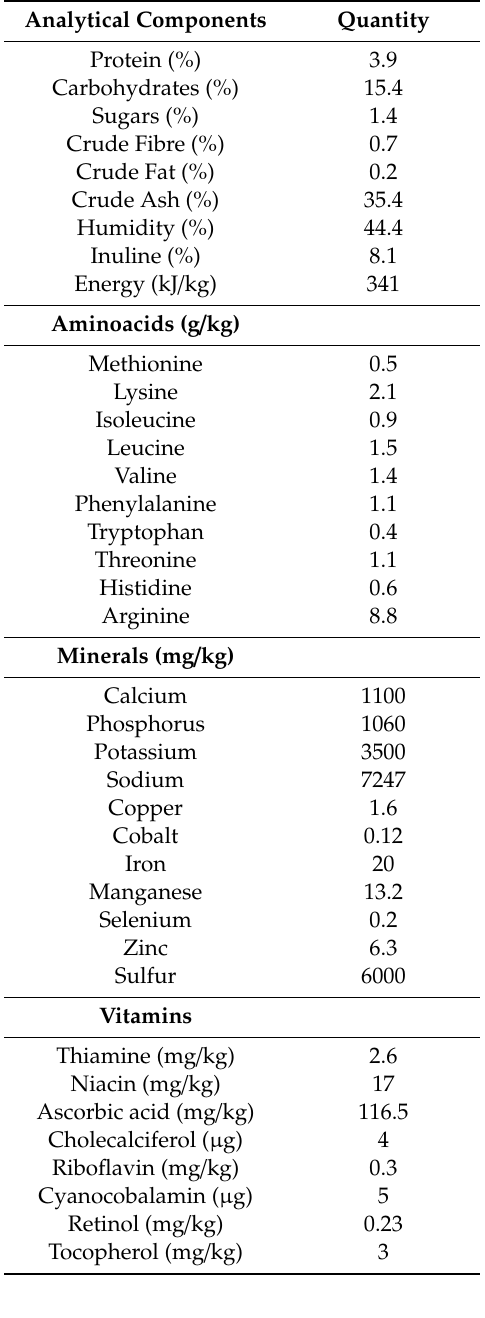
Table 2. Chemical composition and amino acid composition of the purple garlic